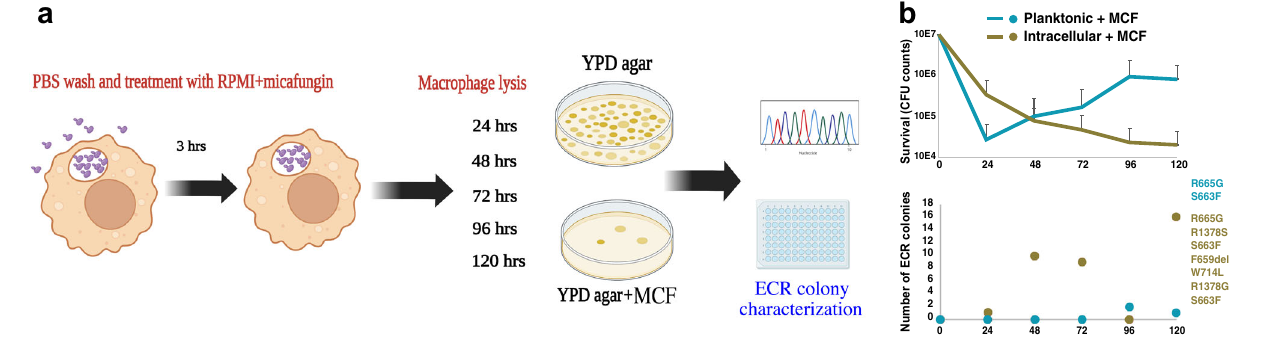
Fig. 4 | ICG develops echinocandin-resistant mutations. a Echinocandin resis- tance and survival rates of C. glabrata cells incubated in macrophages and RPMI containingmicafungin(0.125 µ g/ml)wereevaluated.Ateachtime-point, C.glabrata cells were collected, a portion was spread on YPD to assess survival and the other portionwasplatedonYPDplatescontainingmicafungin(0.125 µ g/ml)todetermine